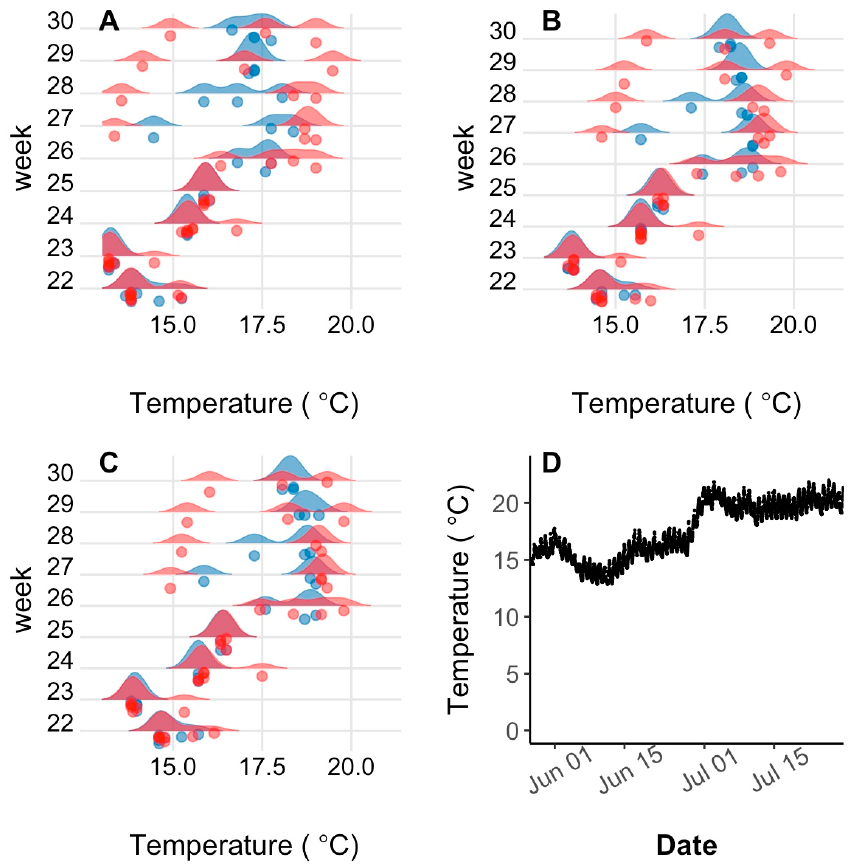
Figure 2. Weekly density (bandwidth 0.3) plots of temperature quantiles for Pete’s Pothole (PPH) transmitter (Vemco VP TP transmitters) logs for diploid (blue) and triploid (red) Blackwater rainbow trout ( Oncorhynchus mykiss) . ( A ) 25th quantile, ( B ) median, ( C ) 75th quantile. In ( A – C ), Y -axis is week of the year and week 22 corresponds to the week of 26 May to 30 May, where fish were stocked into PPH on 26 May, and week 30 corresponds to 21 July to 25 July. Dots on the bottom of each weekly plot indicate the temperature quantile for each individual fish alive in the lake during that week. ( D ) PPH surface temperature through the summer of 2008.